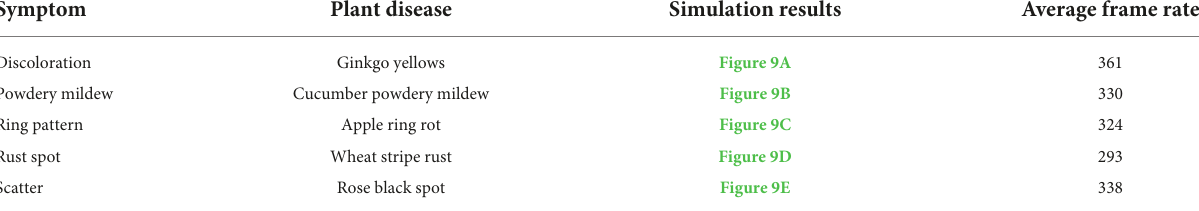
TABLE 2 Average frame rates of different plant